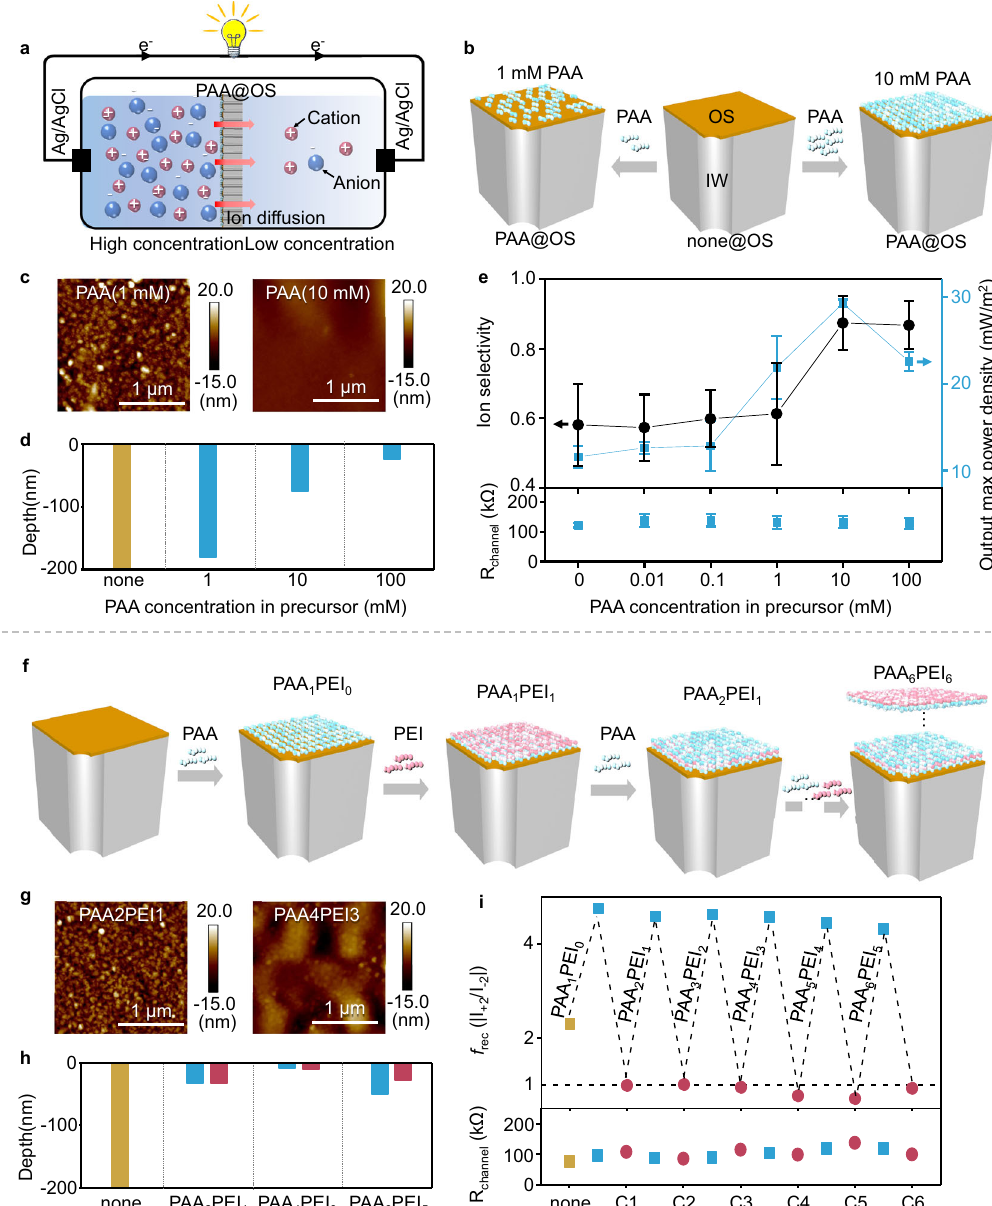
Fig. 4 Effect from FE OS on osmotic energy conversion devices. a A scheme showing the working mechanism of the osmotic energy conversion devices using nanochannel-system. The electricity by reverse electrodialysis is generated under salt gradient using a nanochannel system containing only FE OS . b Fabrication of the nanochannel-system attached with PAA as FE OS (PAA@OS) using precursor with different PAA concentration (1 or 10mM). c AFM of PAA@OS using 1 and 10mM PAA in precursor. d Depth distribution of the part of FE OS in nanochannel-system using precursor solution with different PAA concentration from ToF-SIMS. e Output max power density, ion selectivity and R channel of PAA@OS with different PAA concentration in precursor. f Scheme showing LbL assembly of PAA and PEI at OS sequentially. g AFM of the OS after LbL assembly. h Depth distribution of the part of FE OS (PAA and PEI) in nanochannel-system after LbL assembly. i Reversal f rec through the LbL assembly of PAA and PEI and corresponding R channel . The numerical simulations